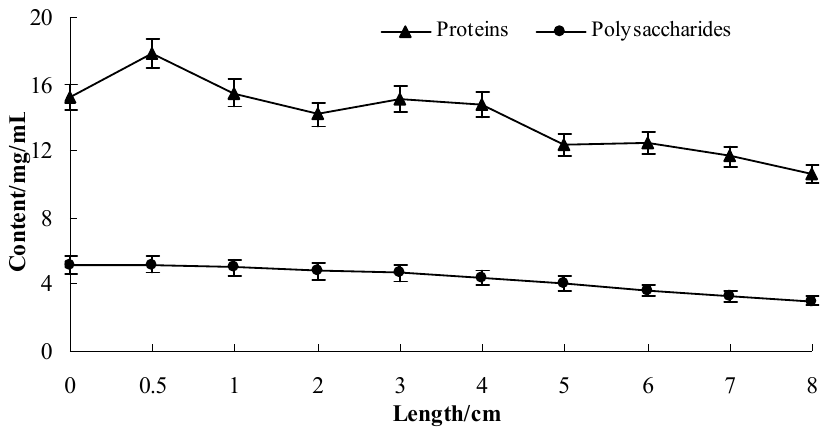
Figure 1. Concentration (mg/mL) of proteins and polysaccharides in soybean sprout extracts taken from different lengths of bean sprouts (n =